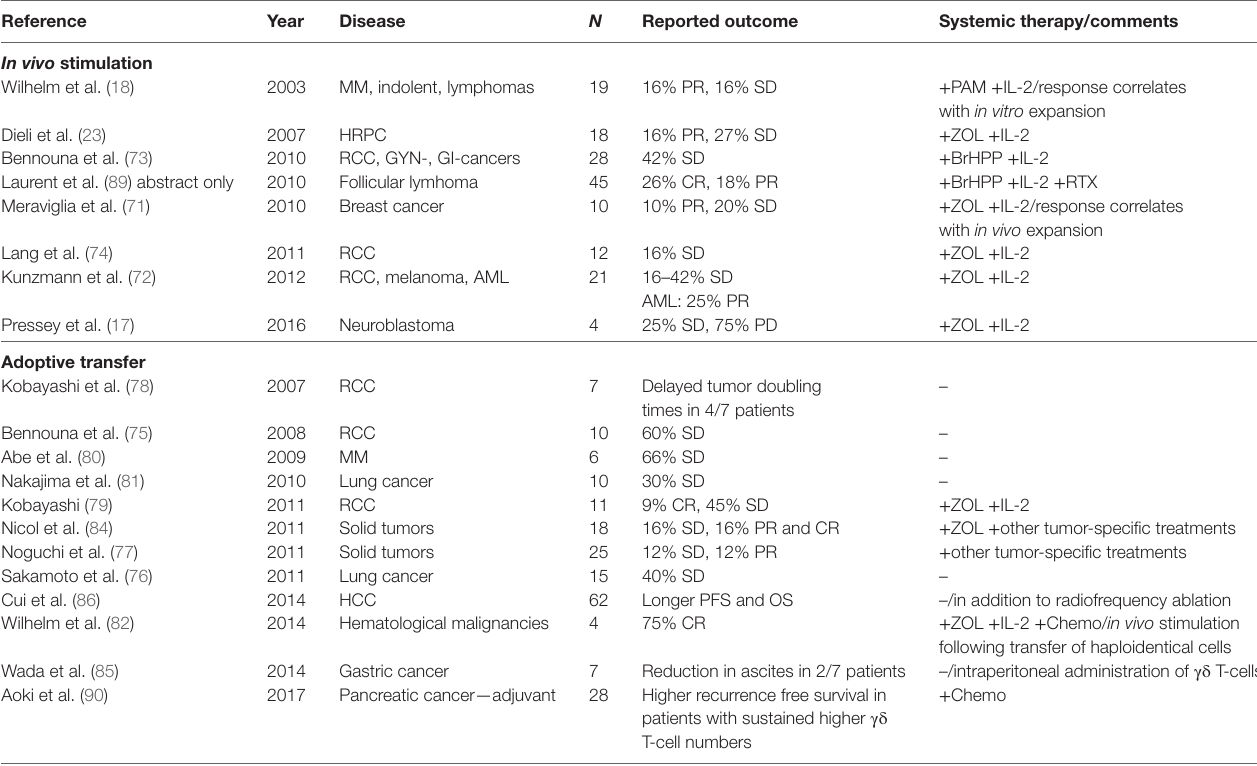
TABLe 1 | Clinical